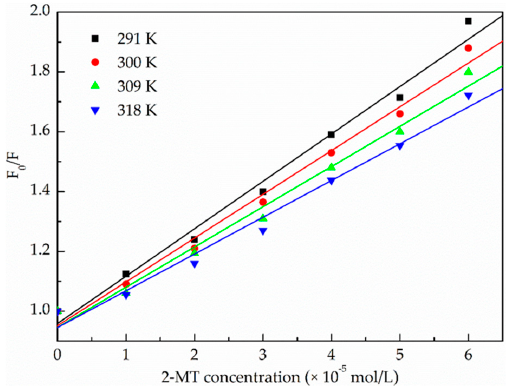
Figure 2. Stern–Volmer linear regression analysis for CAT fluorescence quenching caused by 2-MT under different temperatures (291 K, 300 K, 309 K, and 318 K). Table 1. Stern–Volmer quenching constants for the interaction of 2-MT with CAT under different temperatures (291 K, 300 K, 309 K, and 318 K).